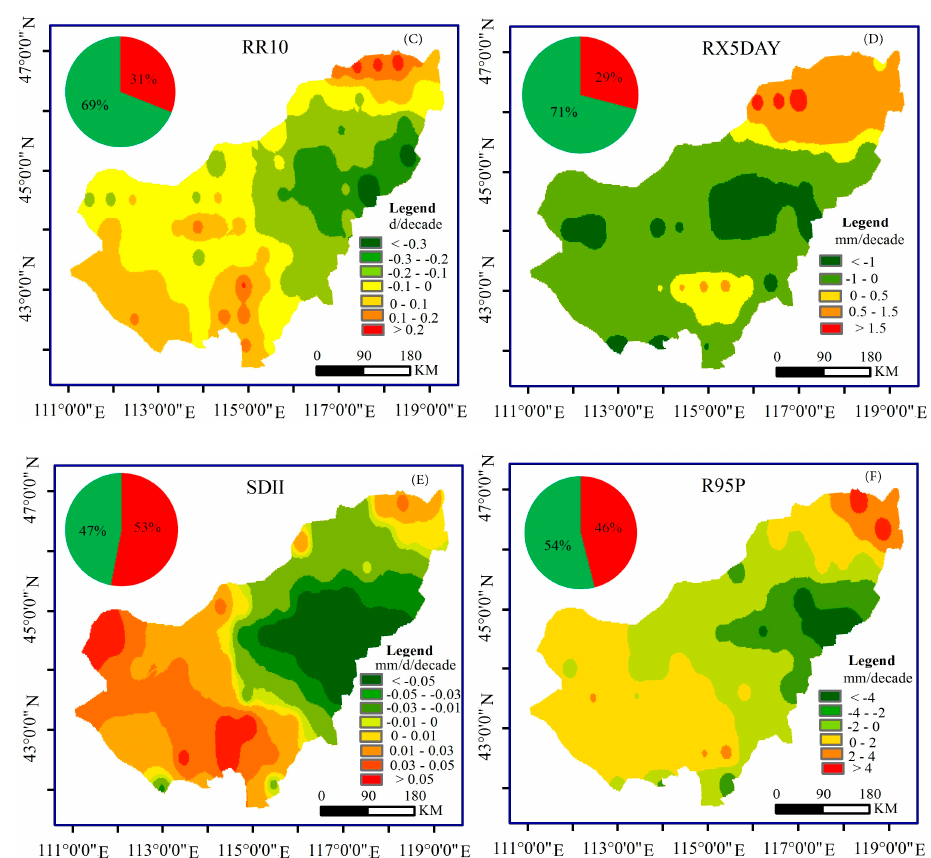
Figure 6. Spatial distribution of the variation trend for the extreme precipitation indices: ( A ) CDD; ( B ) CWD; ( C ) RR10; ( D ) RX5DAY; ( E ) SDII; and, ( F ) R95P. (The red part of the pie chart represents the proportion of the increasing trend, and the green represents the proportion of the decreasing trend).